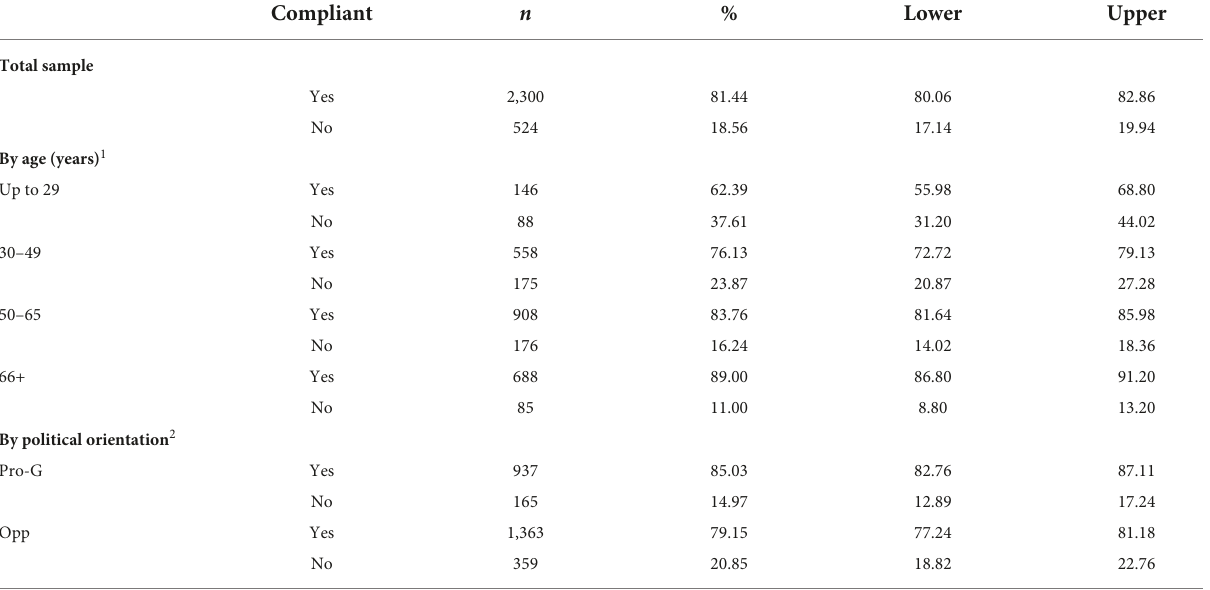
TABLE 2 Compliance with protective health